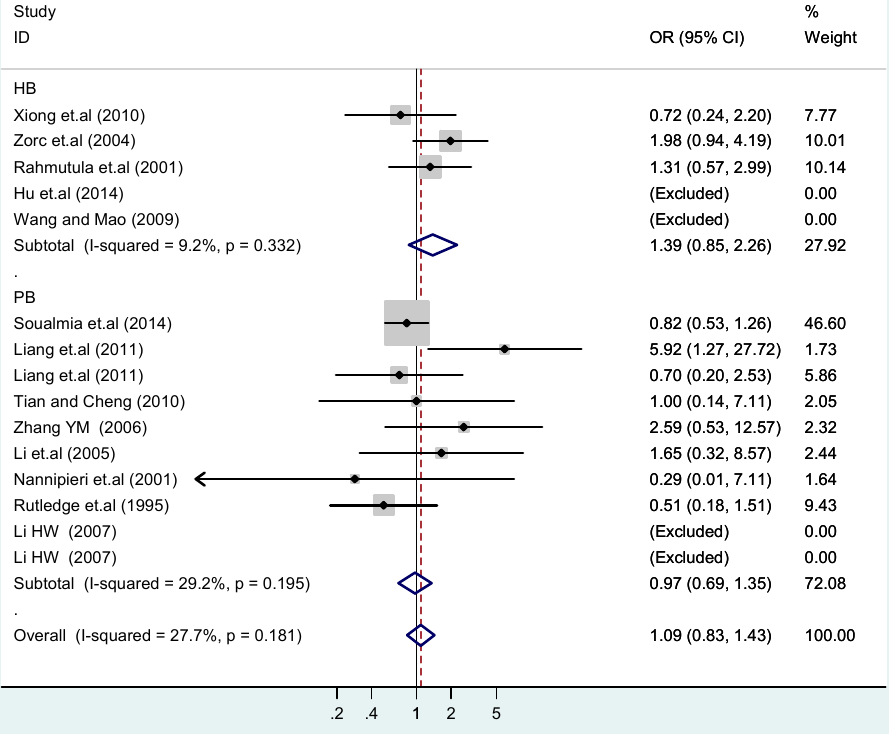
Figure 18. Subgroups in sources of controls of T2238C recessive model CC vs. (TT + TC).